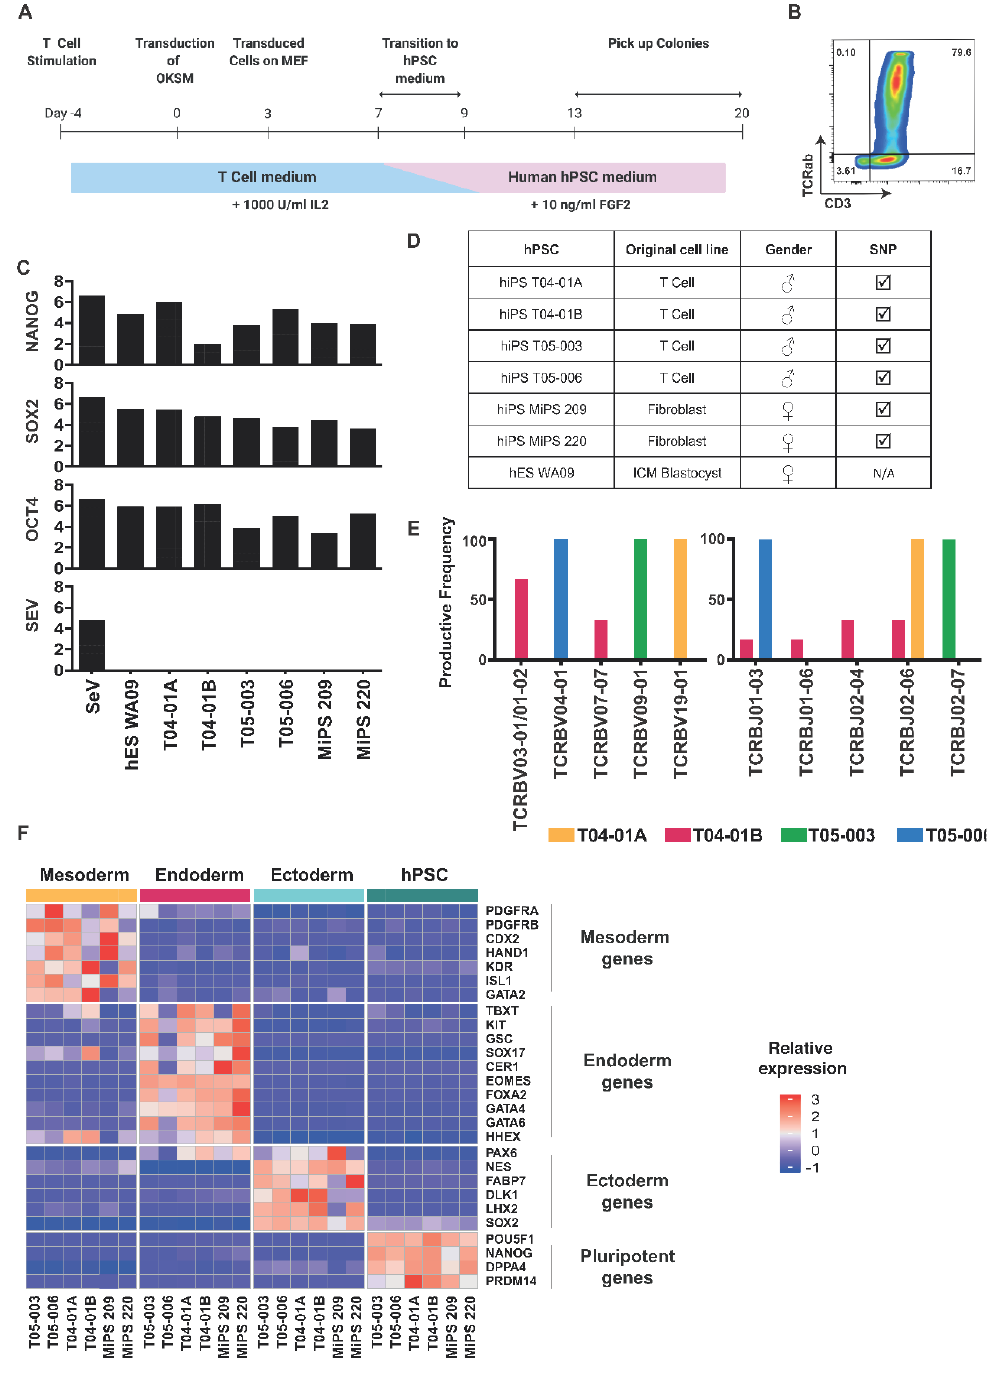
Figure 1. Generation of human iPSCs from T cells. ( A ) Schematic view of the reprogramming protocols. A total of 10 5 activated T cells were seeded on day 0, then they were transduced with 3 Sendai viruses expressing polycistronic KLF4/OCT4/SOX2, MYC, and KLF4 at a ratio of 6:6:3.6, respectively. Cells were split among feeders on day 3 and placed in the hPSC media on day 9. Colonies started to appear around day 13, and they were picked on feeders. ( B ) Representative dot plot of CD3 and TCR αβ on T cells after 4 days of α CD3 and α CD28 mAbs activation. ( C ) qPCR measurement